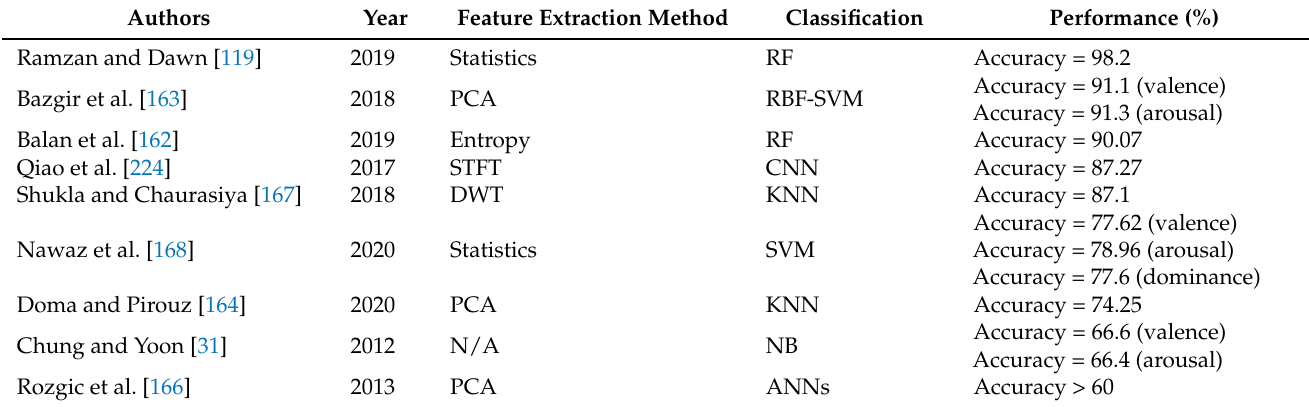
Table 3. Comparison of studies conducted on emotion recognition tasks by using the DEAP data